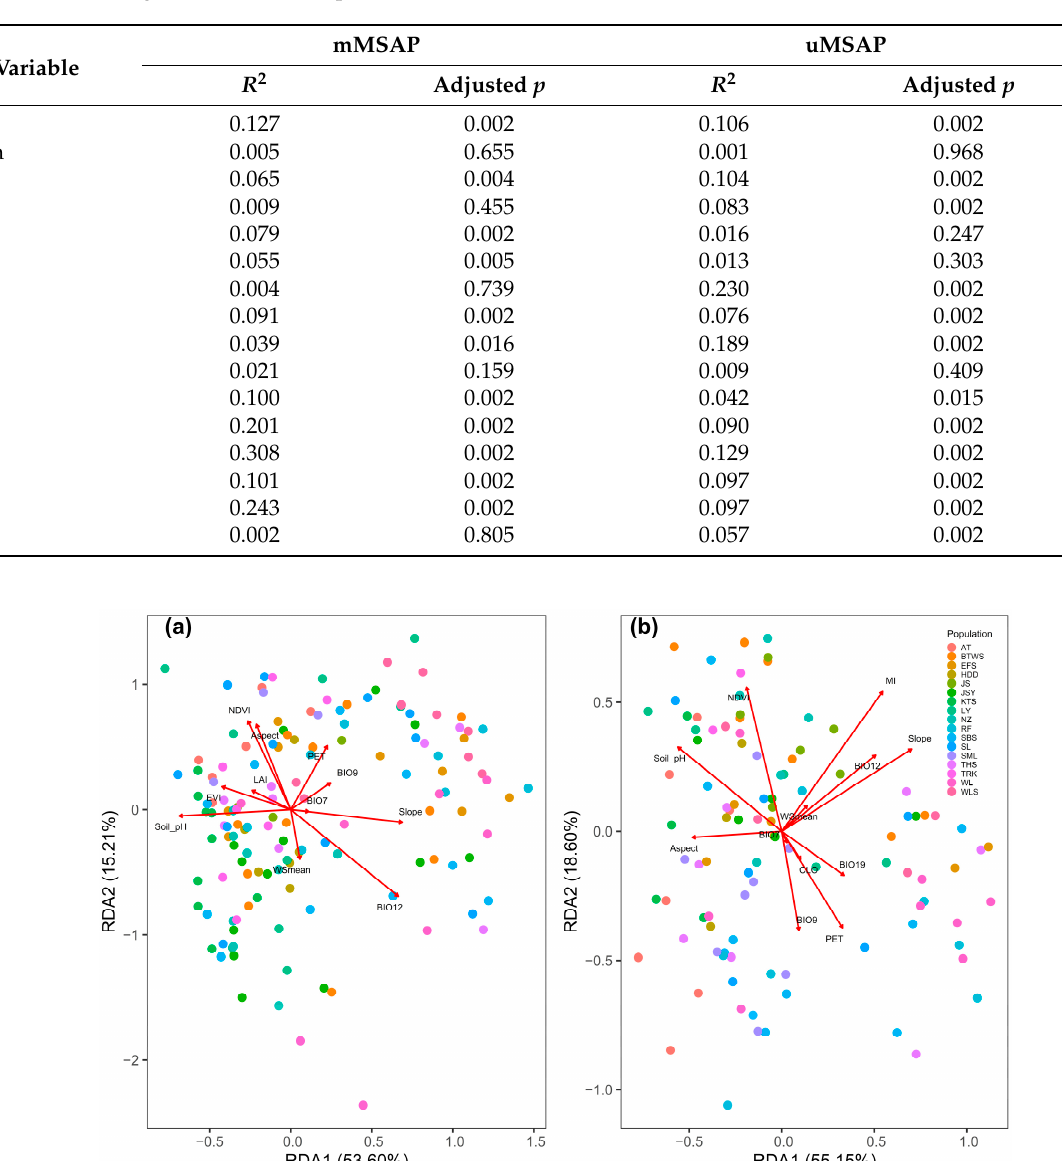
Table 3. Environmental covariates that were significantly associated with outlier epigenetic variation based on the envfit analysis. R 2 , the amount of variation explained by each covariate in the model, was determined using envfit . Adjusted p , the p -value corrected for multiple comparisons, was determined using 5% FDR after 999 permutation tests.